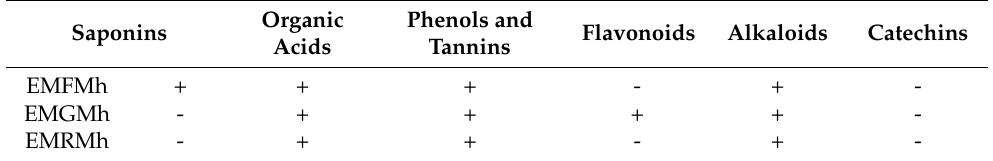
Table 1. Classes of secondary metabolites identified in methanol extracts from leaves, branches, and roots of M. hirsuta